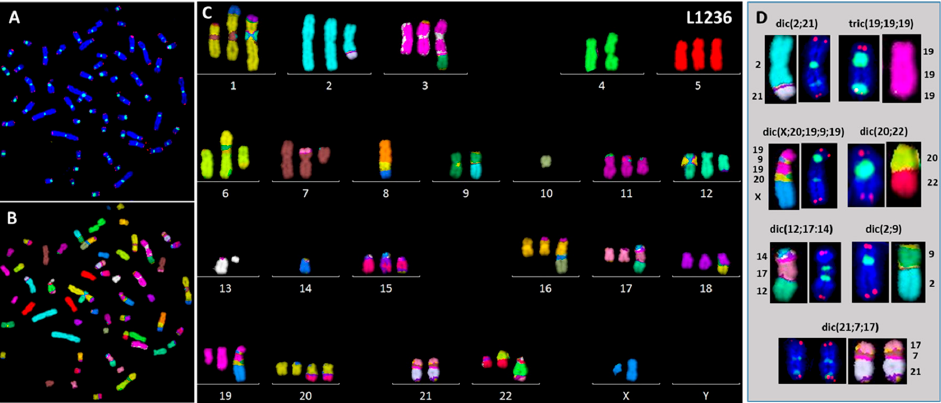
Figure 5. Breakpoints in clonal dicentric chromosomes in L1236 cells by sequential analysis using ( A ) telomere and centromere staining followed by ( B ) M-FISH staining and ( C ) classification of chromosomes. ( D ) Pericentromeric breakpoints detected in clonal dicentric chromosomes (63× magnification).